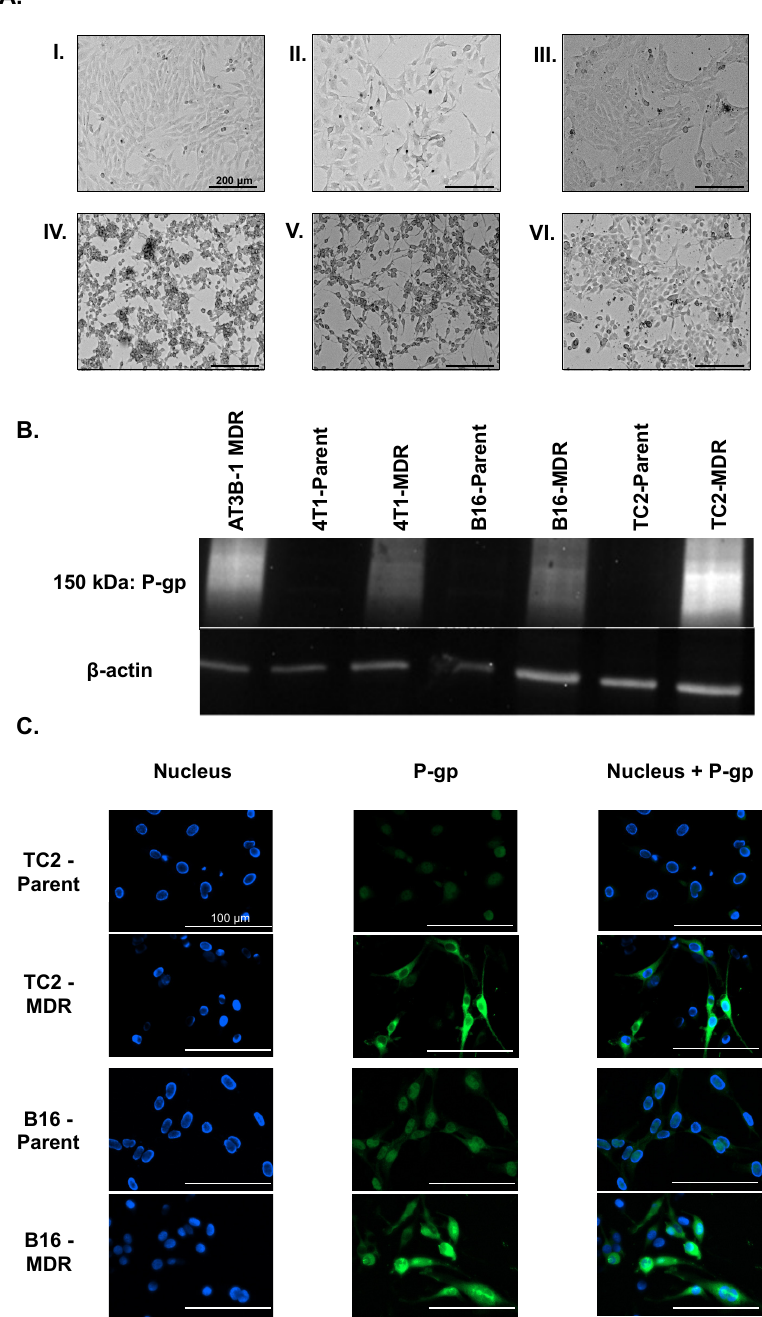
Figure 3. ( A ) MDR cancer cells were derived from parent cancer cell lines by incrementally increasing the Dox concentration in growth media. ( I ) TRAMP-C2 (TC2) prostate parent cancer cell line. ( II ) B16-F10 (B16) melanoma parent cancer cell line. ( III ) 4T1-Luc2 (4T1) breast parent cancer cell line. ( IV ) TC2-MDR cancer cell line. ( V ) B16-MDR cancer cell line. ( VI ) 4T1-MDR cancer cell line. Scale: 200 µm ( B ) Western blot shows the increased expression of P-gp in MDR cancer cells compared to parent cancer cell lines. ( C ) TC2-Parent, TC2-MDR, B16-Parent, and B16-MDR stained with Anti-P-gp-Alexa Fluor 488 antibody conjugate reveals the increased expression of P-gp in MDR-derived cancer cell lines, as well as membrane localization of P-gp.